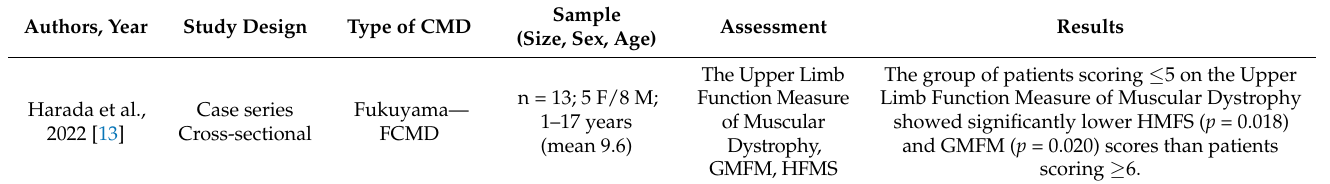
Table 4. Motor outcome measures in patients with FCMD (FCMD: Fukuyama; GMFM: Gross Motor Function Measure; HMFS: Hammersmith Motor Function).